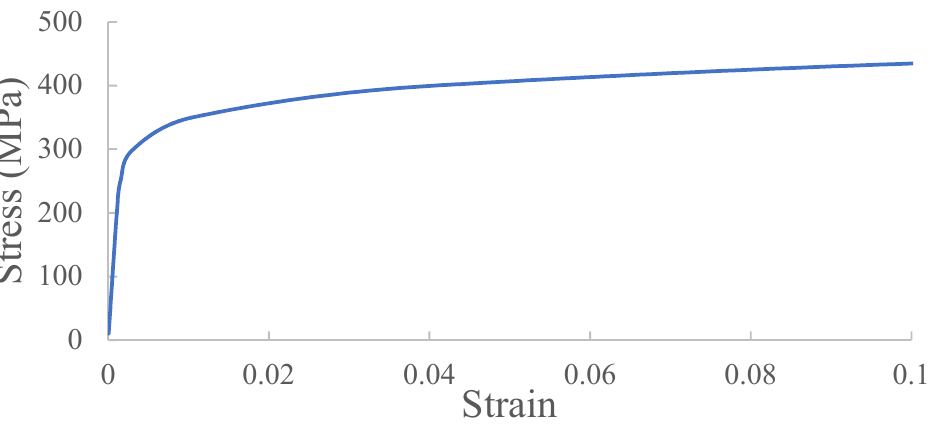
Figure 3. Strain–stress curve applied in numerical calculation.